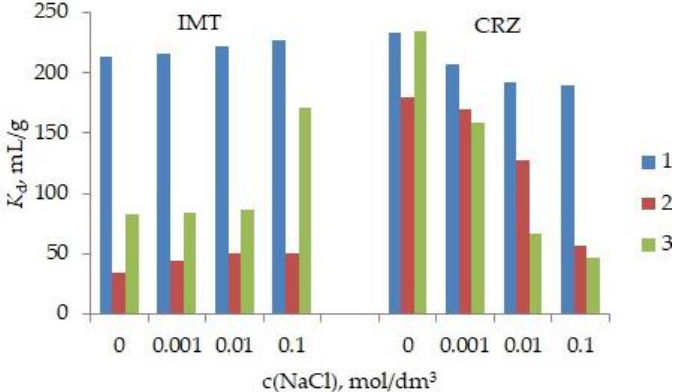
Figure 3. Ionic strength as influencing parameter on IMT and CRZ sorption (1 — suspended TiO 2 , 2 — TiO 2 -GF, 3 — TiO 2 /CNT-GF). 2—TiO 2 -GF, 3—TiO 2